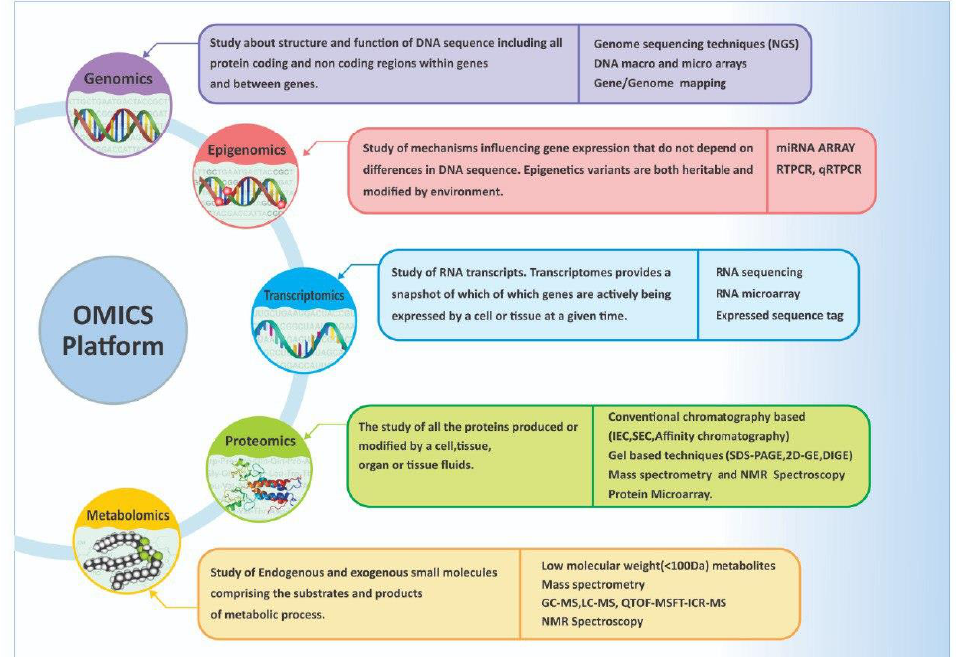
Figure 2. Principles of omics in clinical practice.